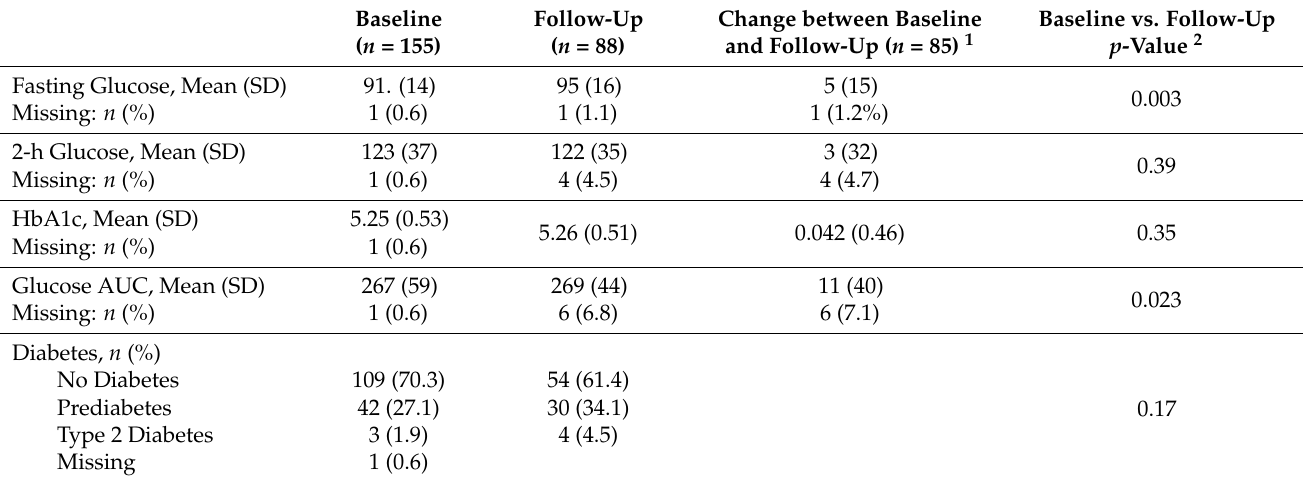
Table 3. Descriptive statistics for glucose outcomes at baseline, follow-up, and change between visits. Baseline